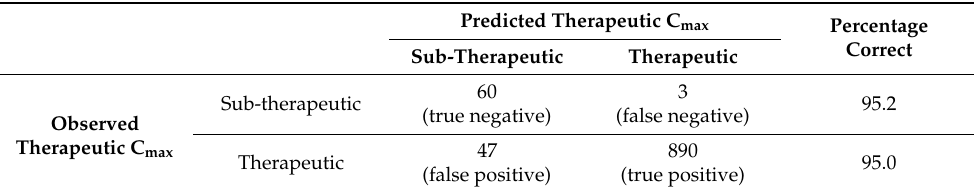
Table 2. Classification matrixes describing the capability of linear regression models to identify individuals with a sub-therapeutic sorafenib steady state C